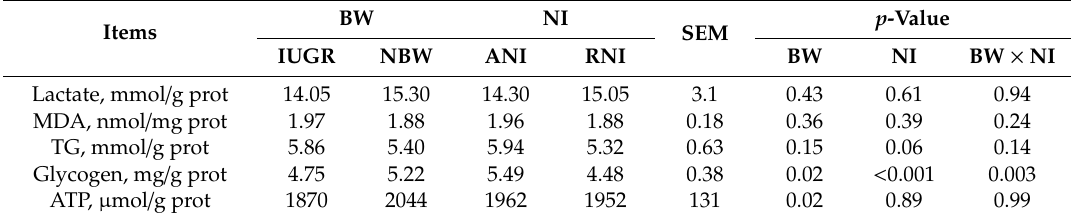
Table 4. E ff ects of the level of nutrient intake on muscle metabolite content of psoas major muscles in intrauterine growth-retarded (IUGR) and normal-birth weight (NBW) piglets.